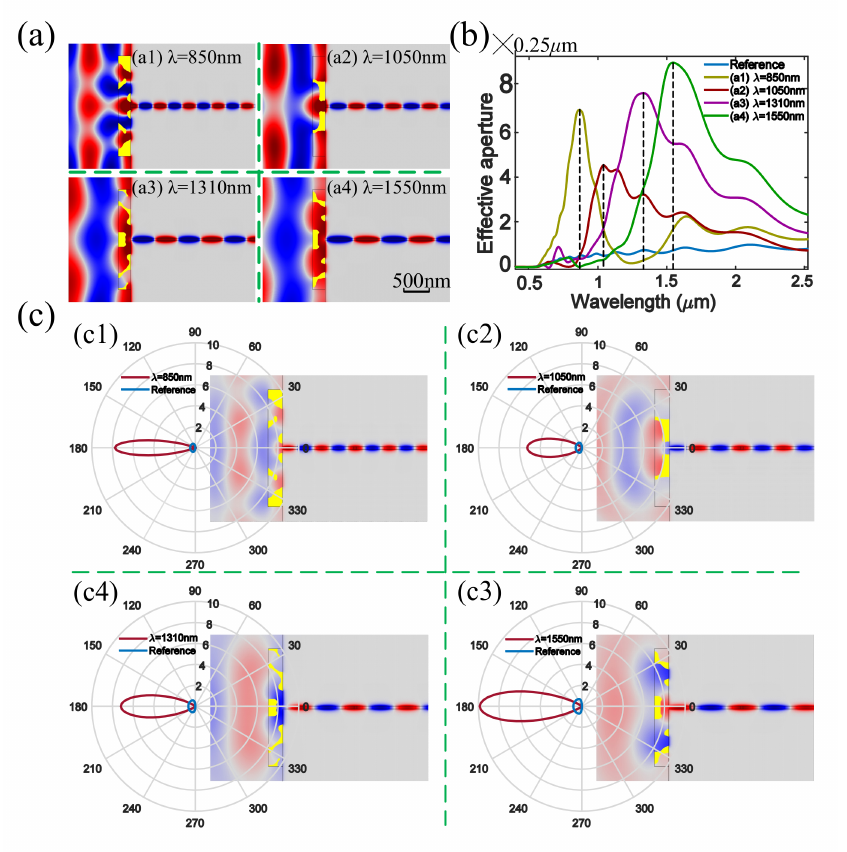
Figure A4. ( a ) Inversely designed nanoantennas for the four communication wavelengths, ( b ) effective-aperture spectra for the four inversely designed nanoantennas, ( c ) emitting perfor- mances of the four inversely designed